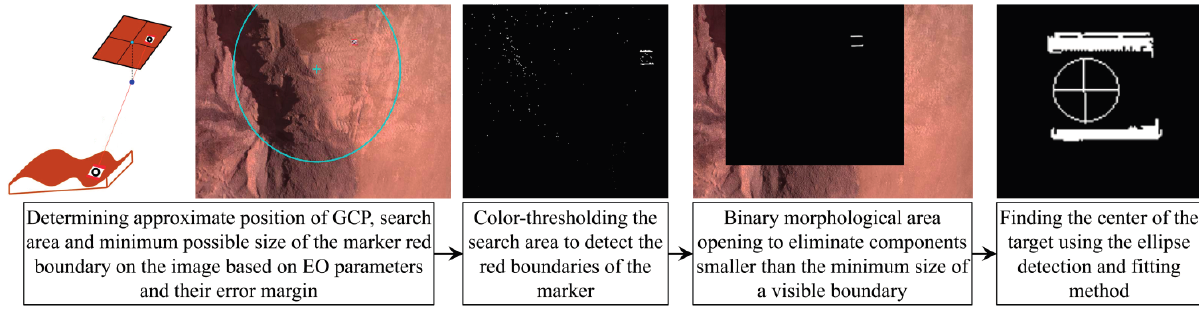
Figure 11. Workflow for automatic detection of